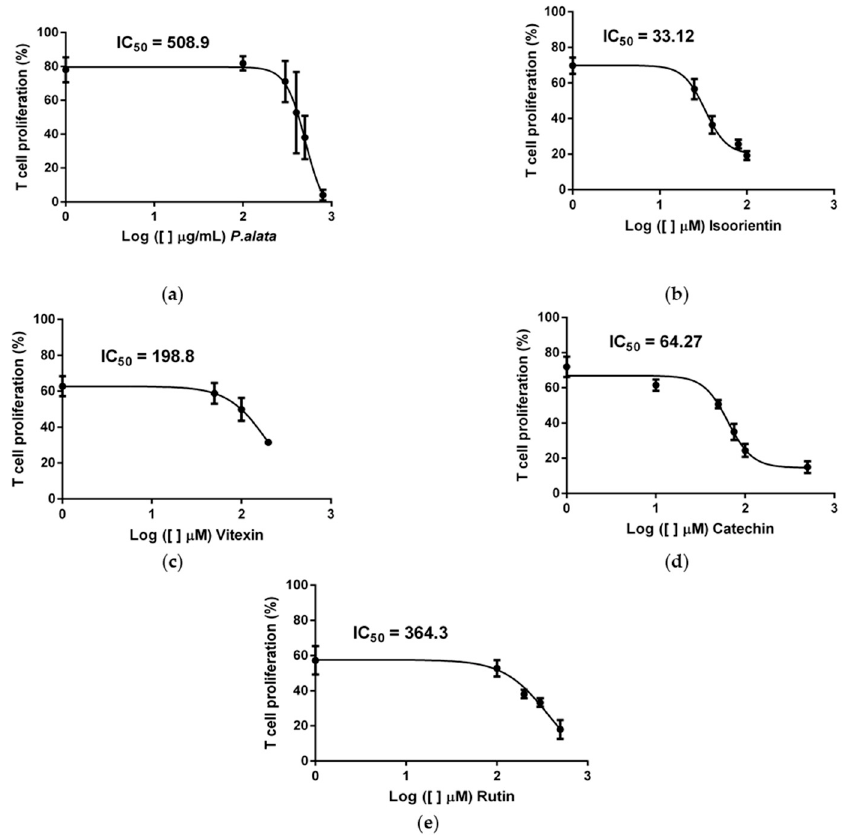
Figure 1. Effect of P. alata extract and polyphenols in Concanavalin A (ConA) proliferation-stimulated T lymphocytes. The dose–response curves of P. alata extract ( a ) and polyphenols: isoorientin ( b ), vitexin ( c ), catechin ( d ) and rutin ( e ) represent the IC 50 of each respective compound calculated by non-linear regression fit modelling as described in the Material and Methods Section; n = 6 with triplicate cell assays.